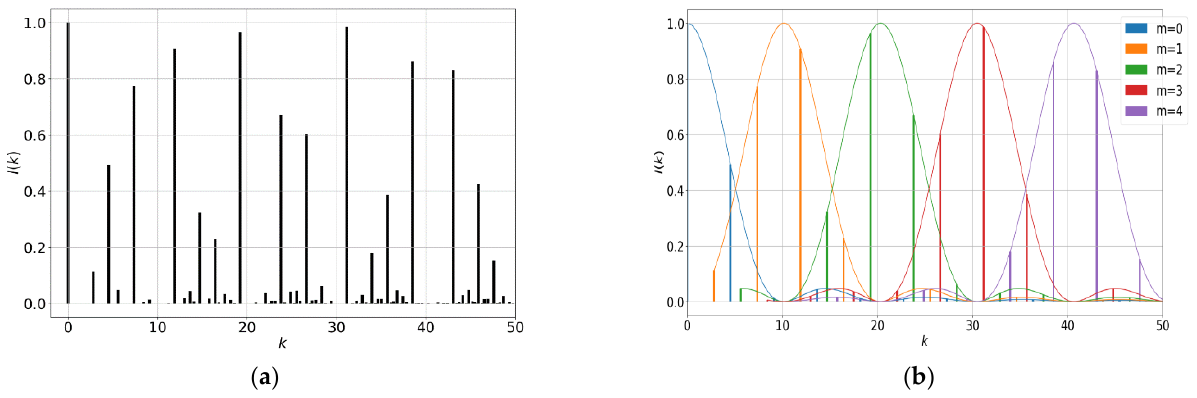
(cid:0) (cid:1) = τ 2 + 1 2.81 . . ., indexes